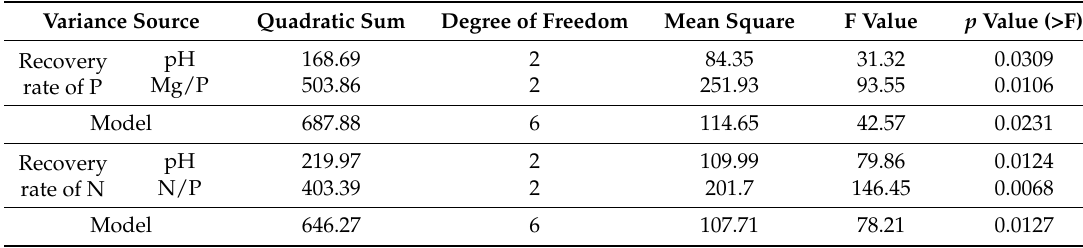
Table 4. Variance analysis of the model.